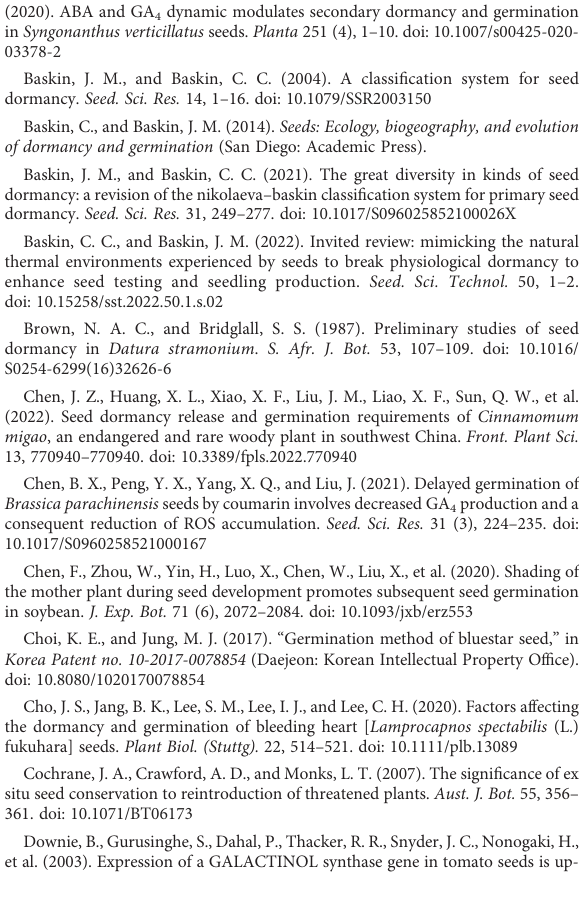
SUPPLEMENTARY FIGURE 1 Normal seedlings and abnormal germination of scari fi ed seeds of Amsonia elliptica germinated in Petri dishes (A) and soil (B) . The black arrow is a normal